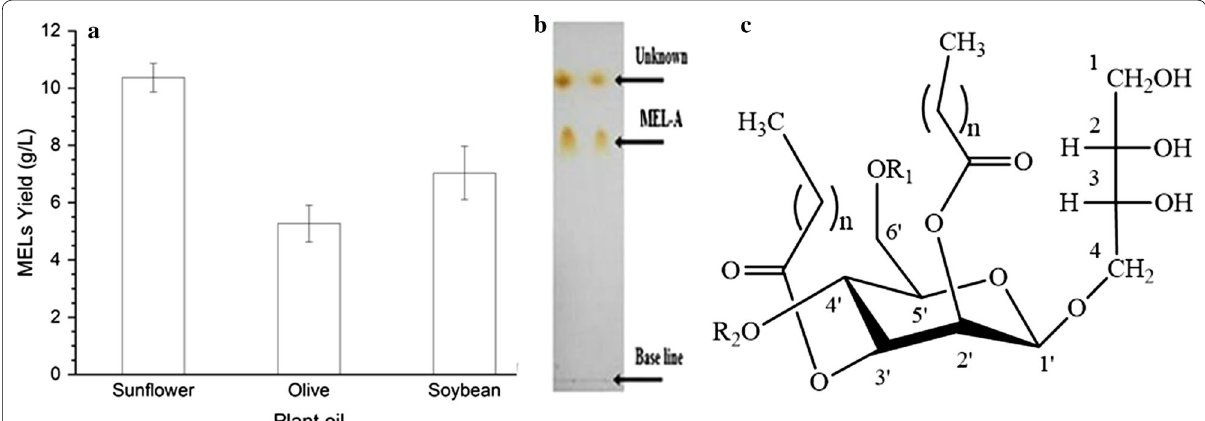
Fig. 1 a Comparison of crude MEL production from different Carbone source; b analysis of MEL production by TLC; c structure of mannosylerythritol lipid